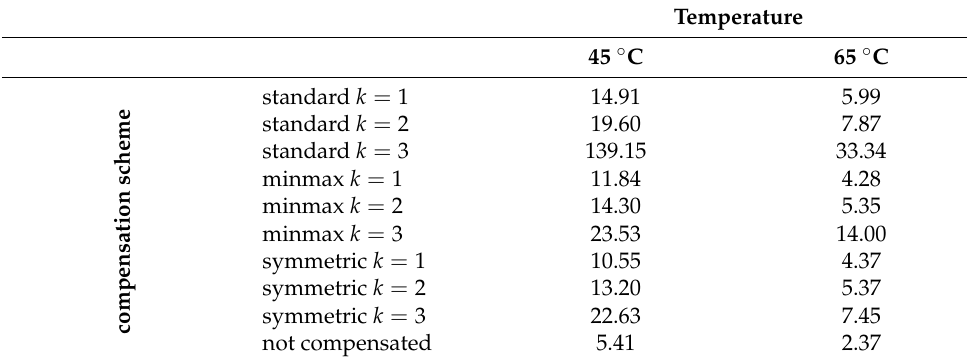
Table 2. D ef f coefficient for corr damage index obtained for specimen no. 2 (temperature measured at the reference point of the surface).